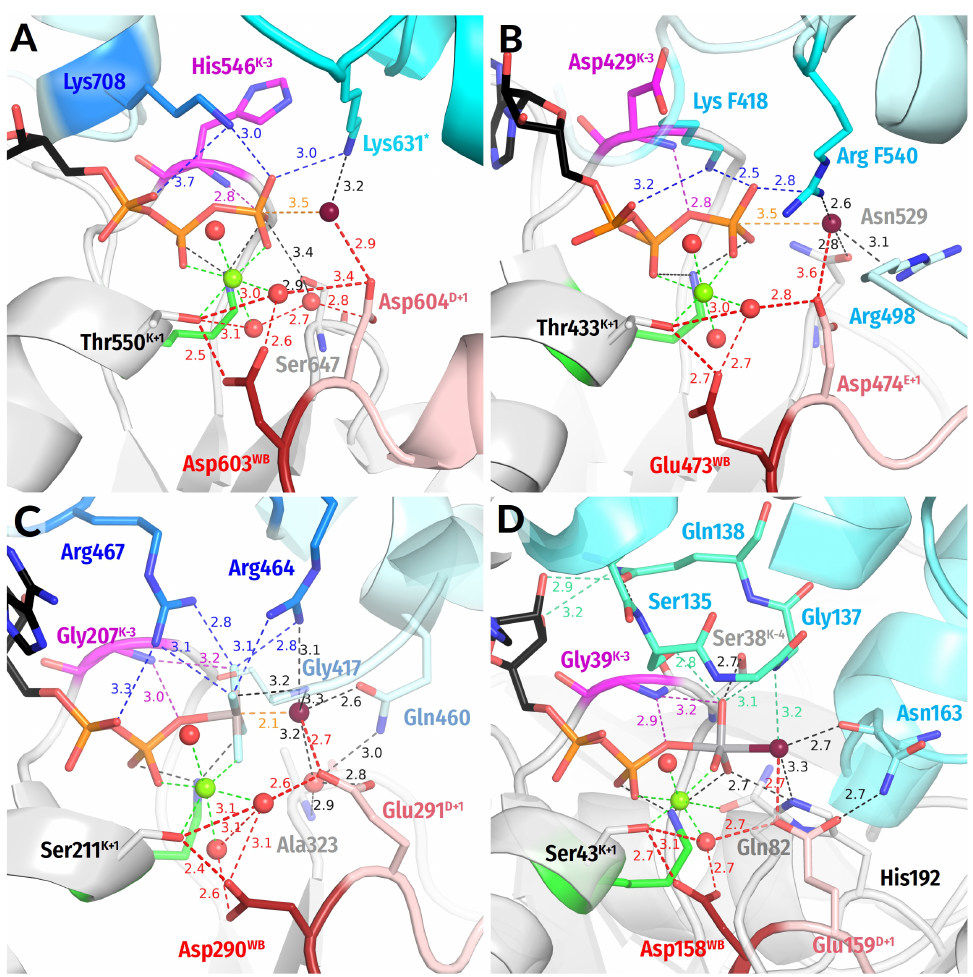
Figure 5. Representatives of AAA+ ATPases, SF3 helicases, SF2 helicases, and ABC ATPases . The Arg residues from the C-terminal helical domain of the same monomer are shown in deep blue (panel ( C )). The LSGGQ motif is shown in green-cyan, and the VO 43— moiety in grey and red (panel ( D )). Red dashed lines mark protonic connections between W cat and Asp WB . Other colours are as in Figures 1E,F and 3. All distances are given in ångströms. ( A ) N-ethylmaleimide sensitive factor (PDB ID 1NSF [109]). ( B ) Replicative hexameric helicase of SV40 large tumor antigen